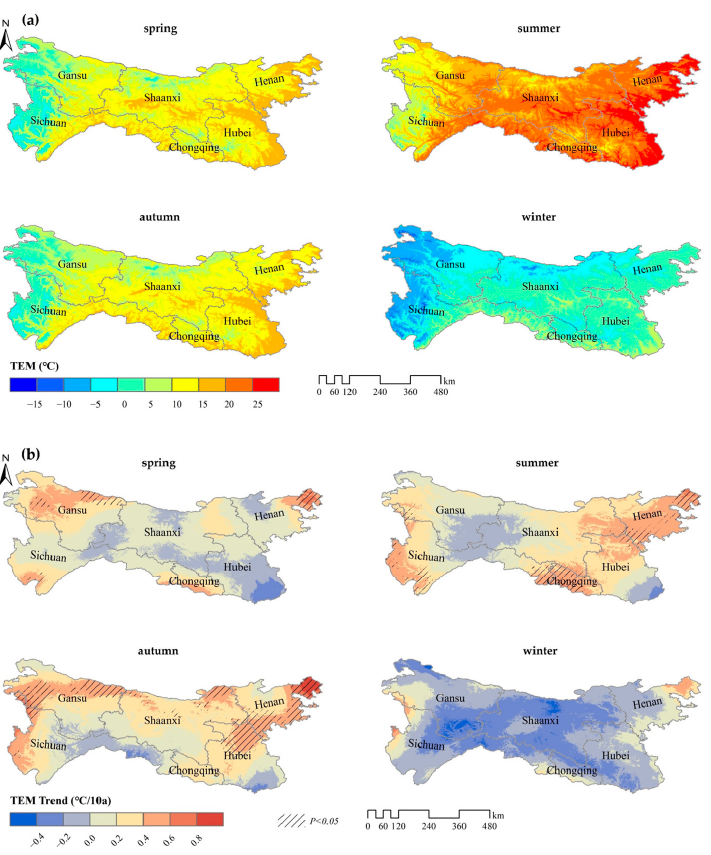
Figure 9. Change of seasonal average TEM spatial pattern in the QBM from 2000–2020. ( a ) Seasonal average; ( b ) Seasonal change trend rate.